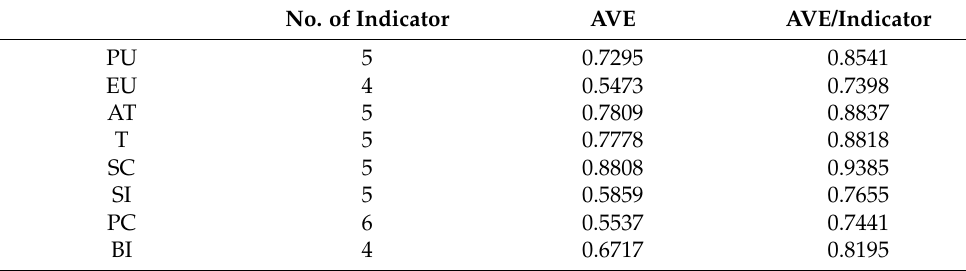
Table 9. Convergent and discriminant